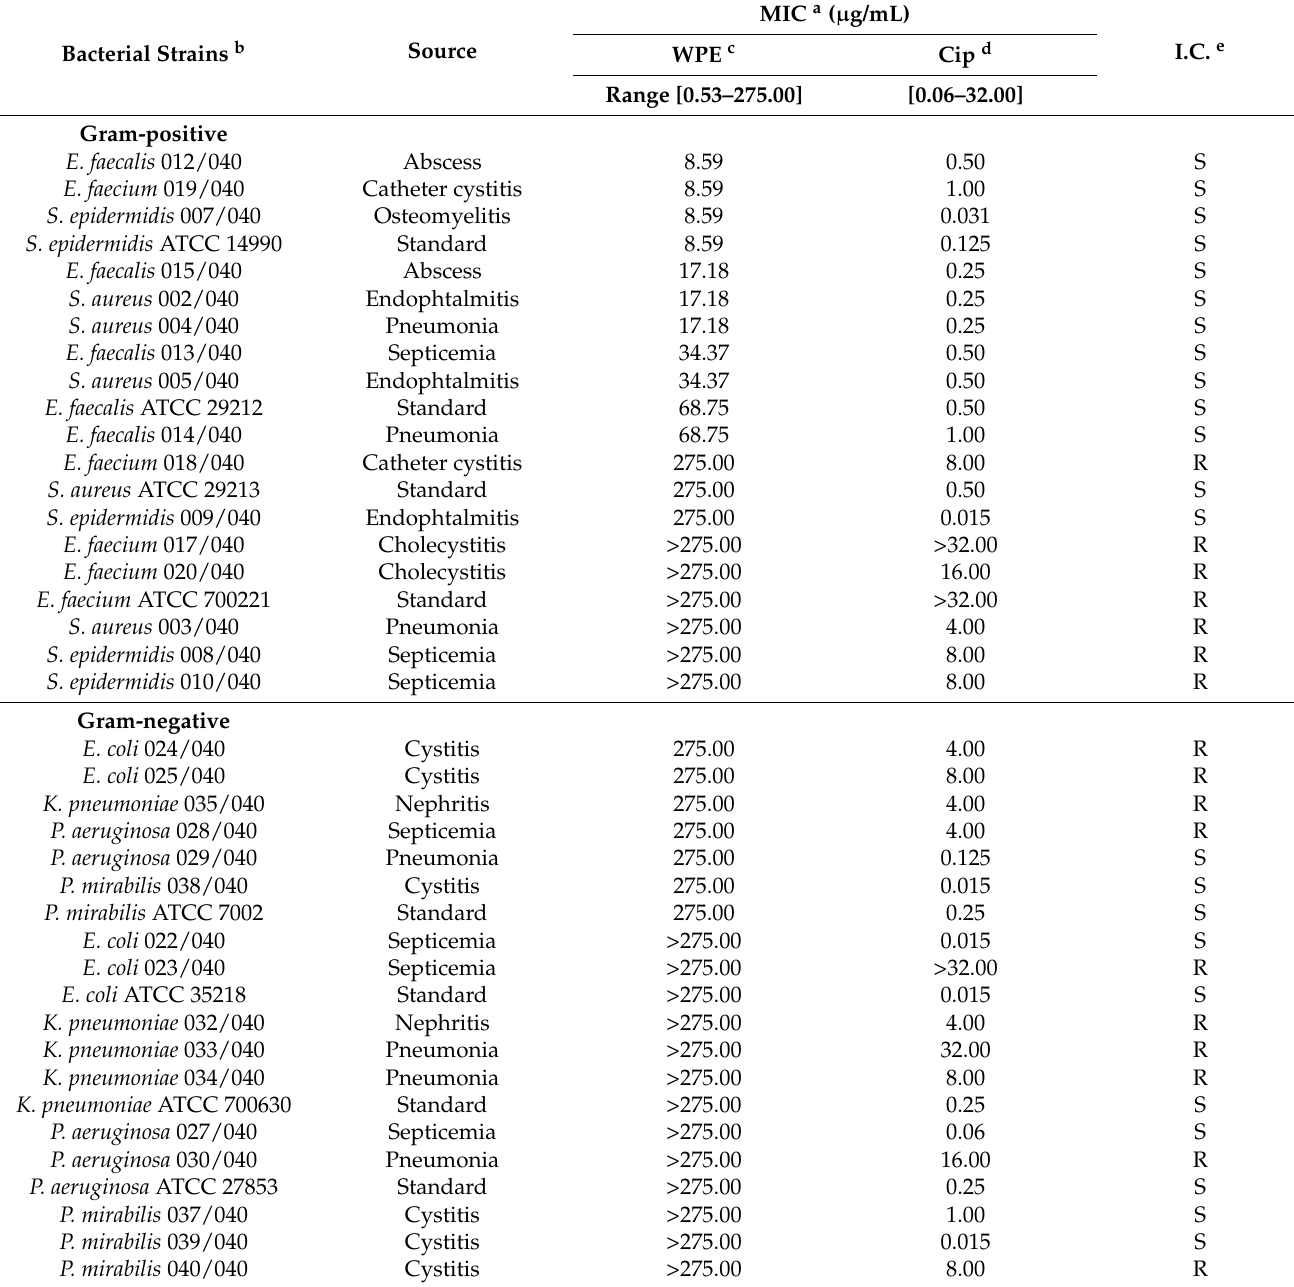
Table 2. Antibacterial activity of walnut pellicle extract against Gram-positive and Gram-negative